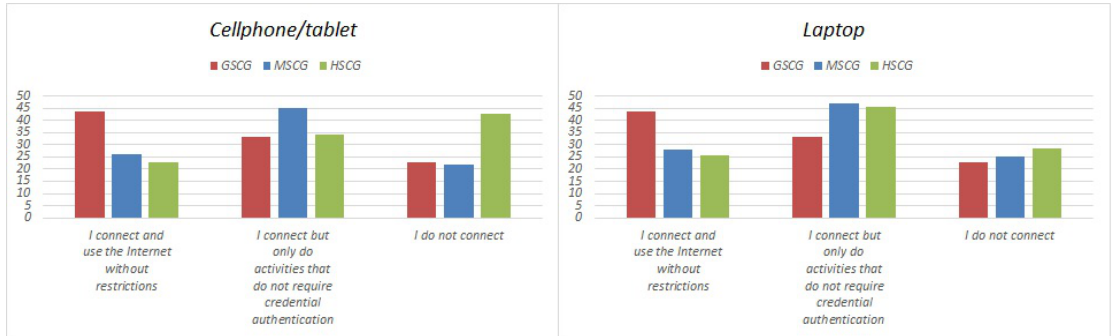
Figure 5. If you find free Wi-Fi, what do you do with your mobile device?